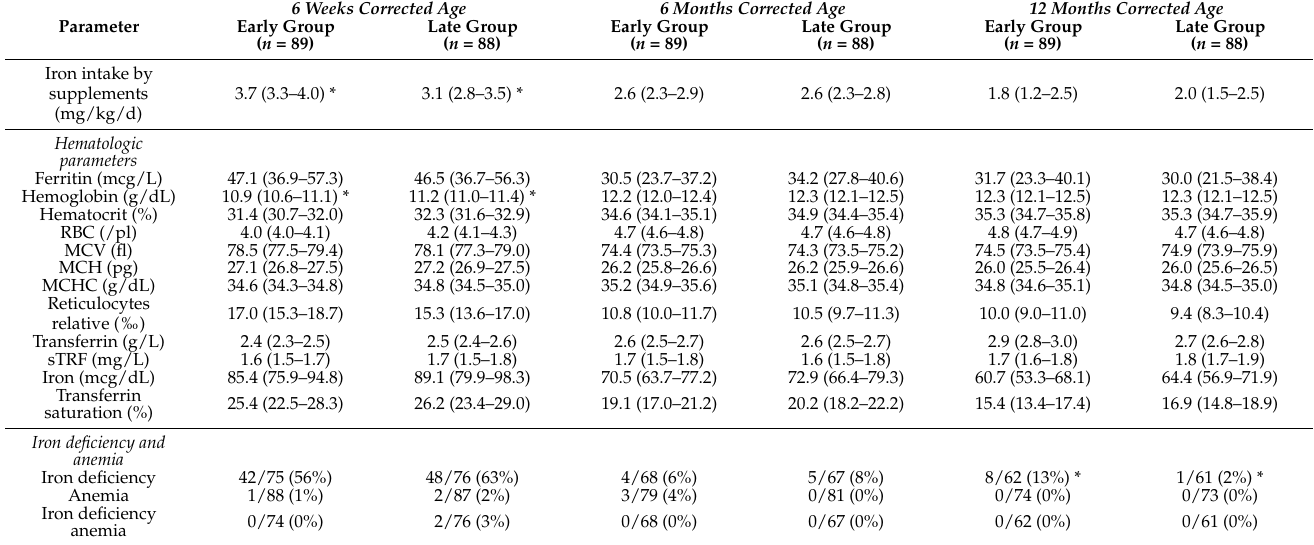
Results from the mixed effects model analysis on iron status are shown in Table 2.